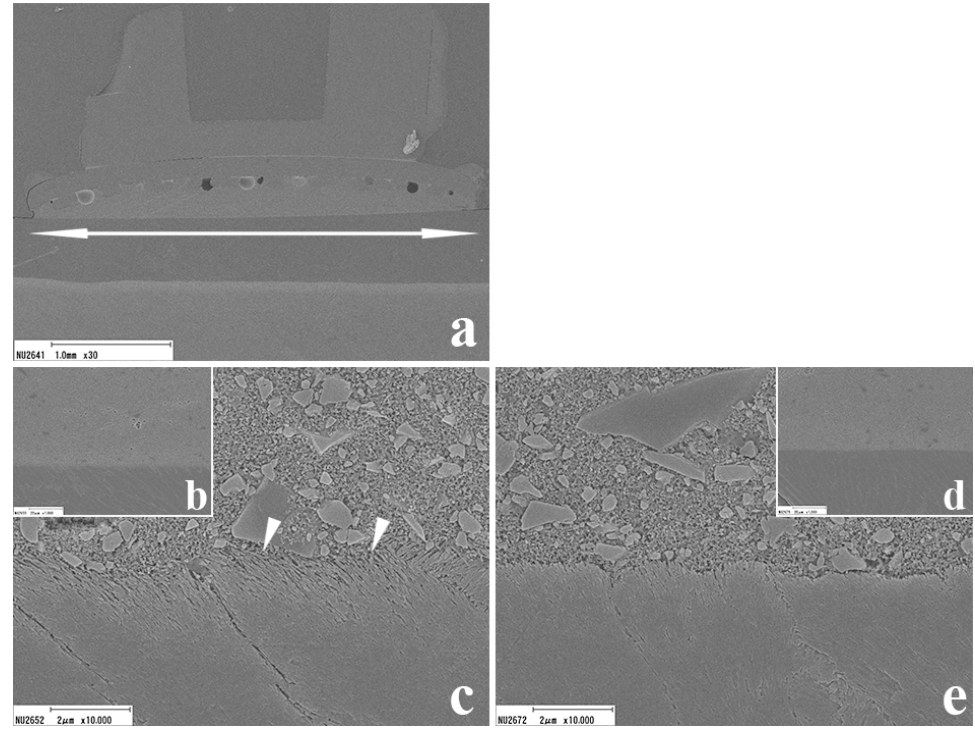
Figure 3. Representative SEM images of the orthodontic adhesive paste/enamel interface in UB. The whole interface (arrow range) region showed excellent adaptation (( a ): magnification 30×). In the pre-etched region (( b ): magnification 1000 ×, ( c ): magnification 10,000×), a typical etching pattern and resin enamel tags were clearly observed (arrowheads). The non-etched region (( d ): magnification 1000×, ( e ): magnification 10,000×) showed neither the typical etching pattern nor resin enamel tags.